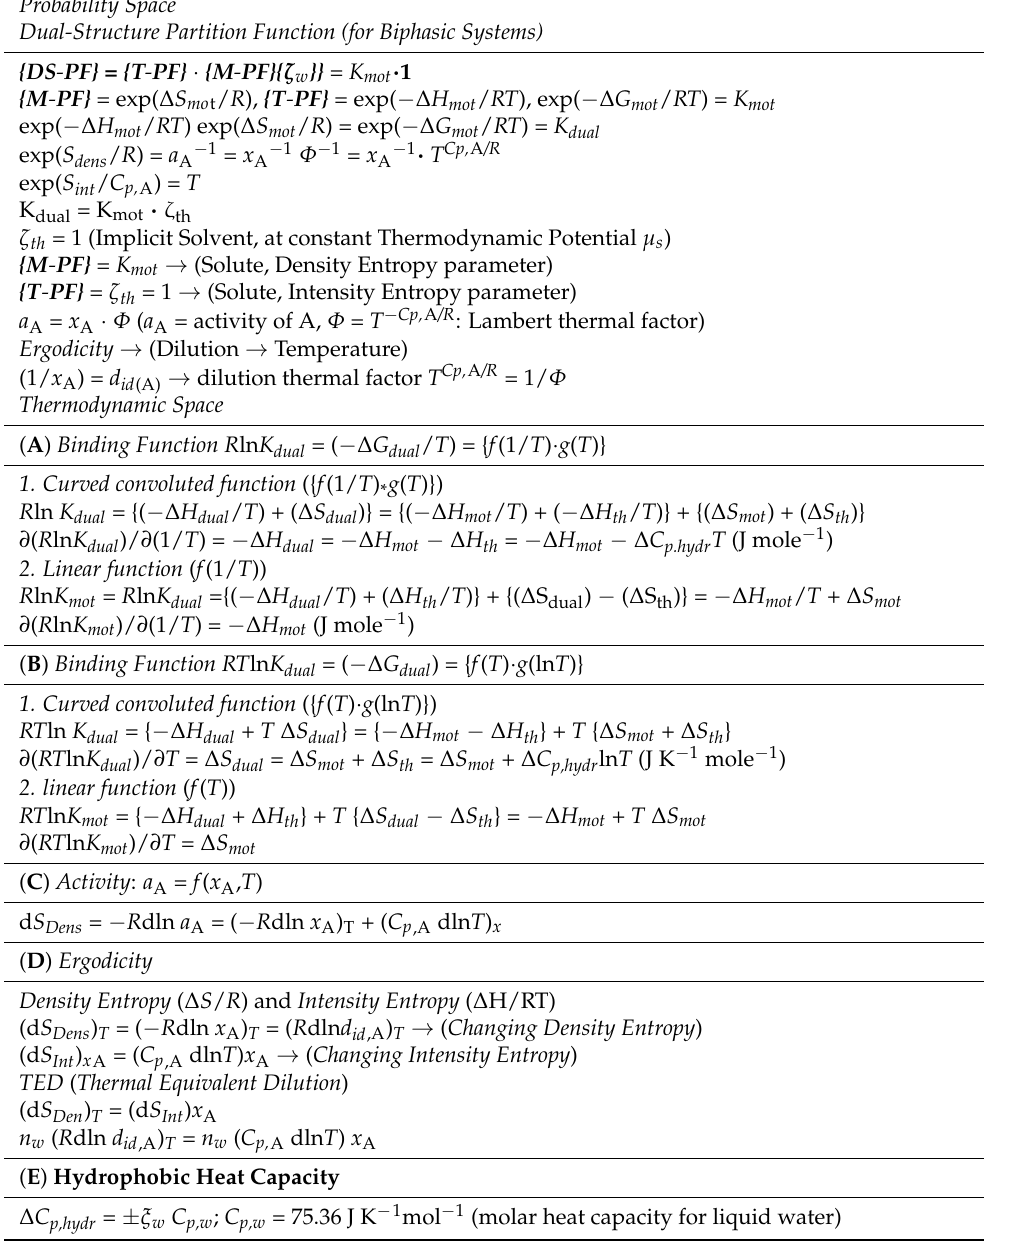
Table A1. Ergodic Algorithmic Model ( EAM , see ref.